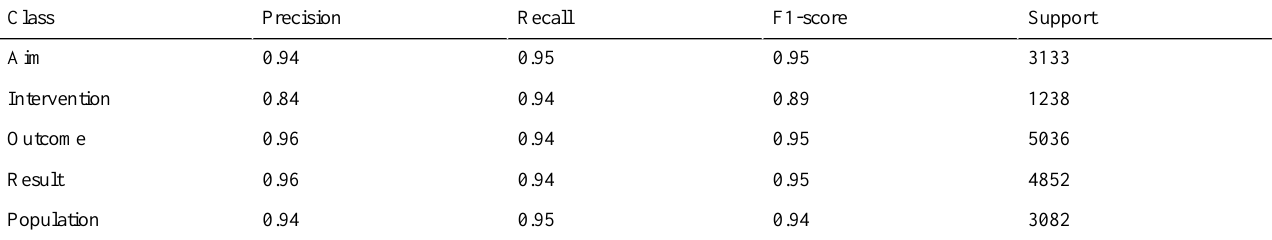
Table 8. Precision, recall, F1-score, and support for individual classes of the proposed deep-learning model.